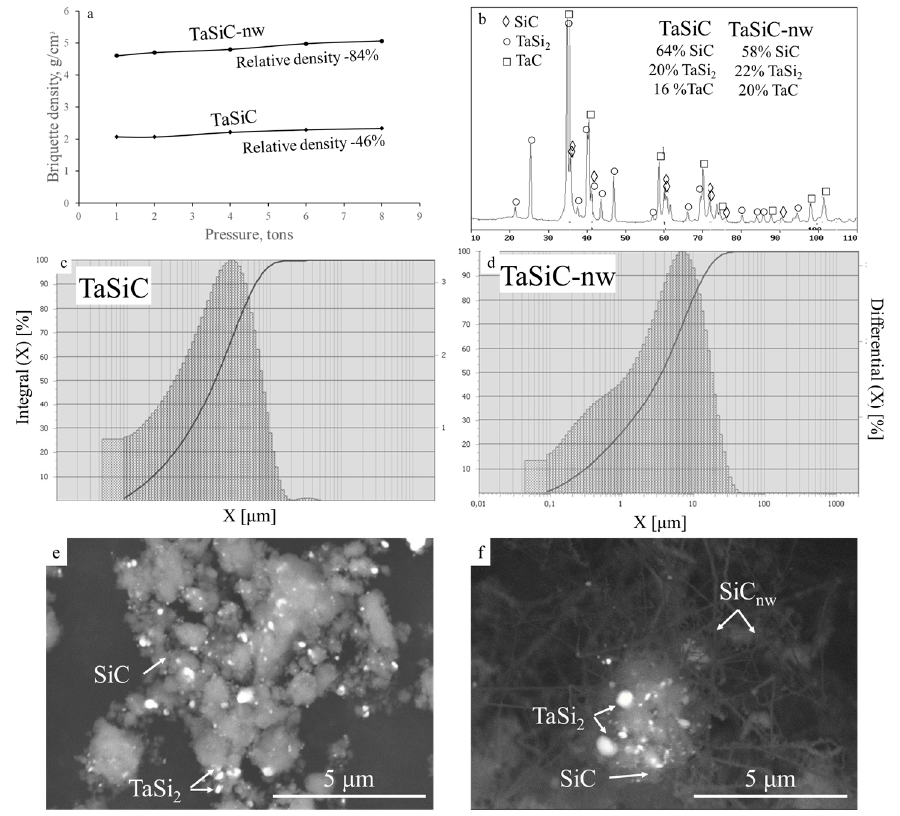
Figure 1. Compressibility curves (one-sided uniaxial pressing) of TaSi 2 -TaC-SiC ceramic powders (TaSiC) and discretely-reinforced TaSi 2 -TaC-SiC-SiC nanowire composition (TaSiC-nw). ( a ) XRD spectrum for TaSiC powder and phase compositions (wt %) for TaSiC and TaSiC-nw powders; ( b ) Particles size distribution for TaSiC ( c ) and TaSiC-nw ( d ) powders; SEM images of TaSiC ( e ) and TaSiC-nw ( f ) powders after milling.